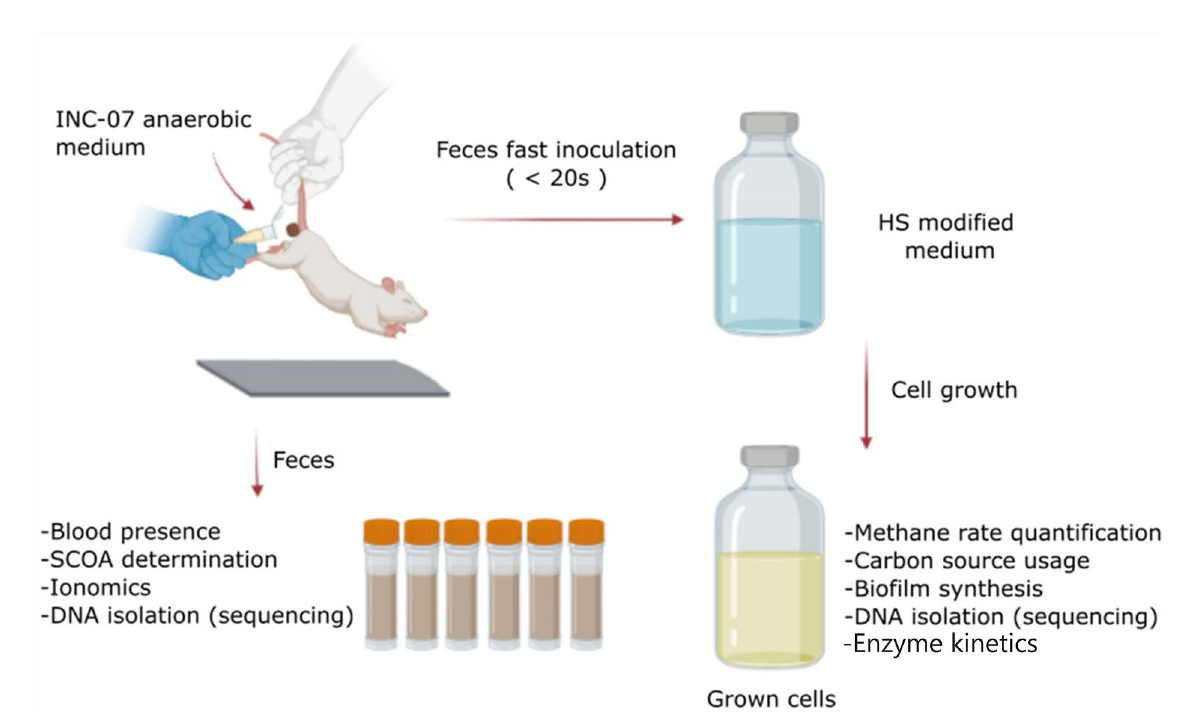
FIGURE1 Scheme of the protocol followed in this study. Feces were collected from control and hepatoma rats just before euthanasia. The samples were used to determine changes in short-chain organic acids (SCOAs), ionomics, blood presence, and metagenomic analysis using 16S rRNA gene. On the other hand, a fraction of the feces was used for a quick inoculation in a medium designed for the growth of anaerobic microorganisms (INC-07 medium), to determine changes in abundance and variability of cultured species by analysis of 16S rRNA gene, biofilm synthesis, metabolites (SCOA production and carbon source consumption), enzyme kinetics, and ROS production. Created with